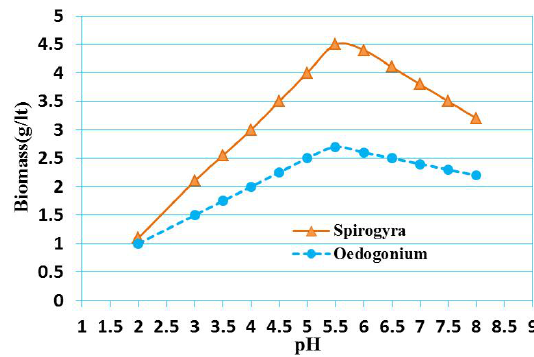
Figure 3. Biomass content (g/lt) of Spirogyra and Oedogonium Algae samples grown in the monosodium glutamate wastewater solution at different pH